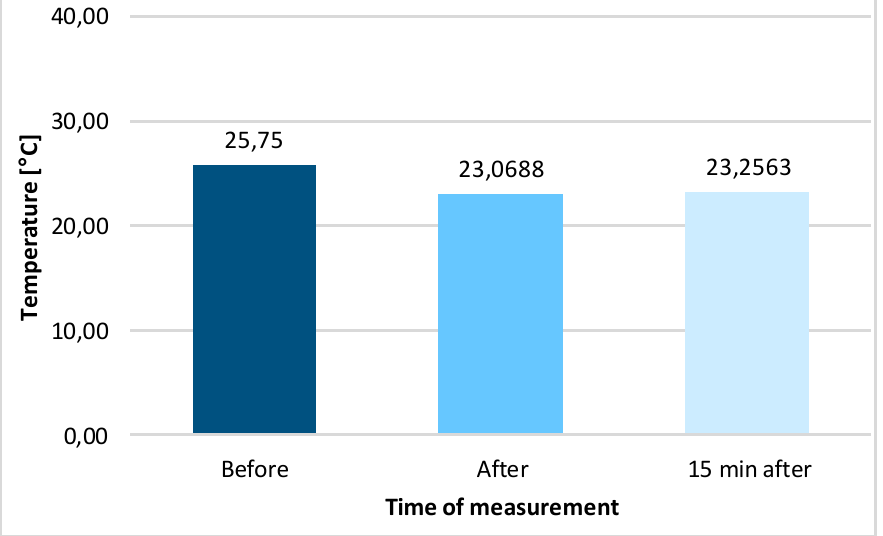
Figure 3. Average external temperature values measured on the palm of the right hand before, after and 15 minutes after winter